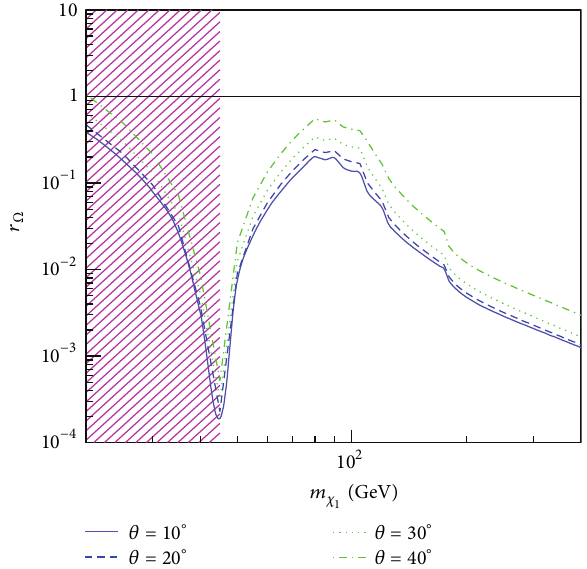
Figure 1: Relative relic density 𝑟 Ω of stable fourth-generation neutrino 𝜒 1 as a function of its mass for mixing angle values 𝜃 = 10 ∘ (solid), 20 ∘ (dashed), 30 ∘ (dotted), and 40 ∘ (dot-dashed). The shaded region is excluded by LEP-2 data [1] in the case of 𝜒 1 being a Dirac fermion. Plot from